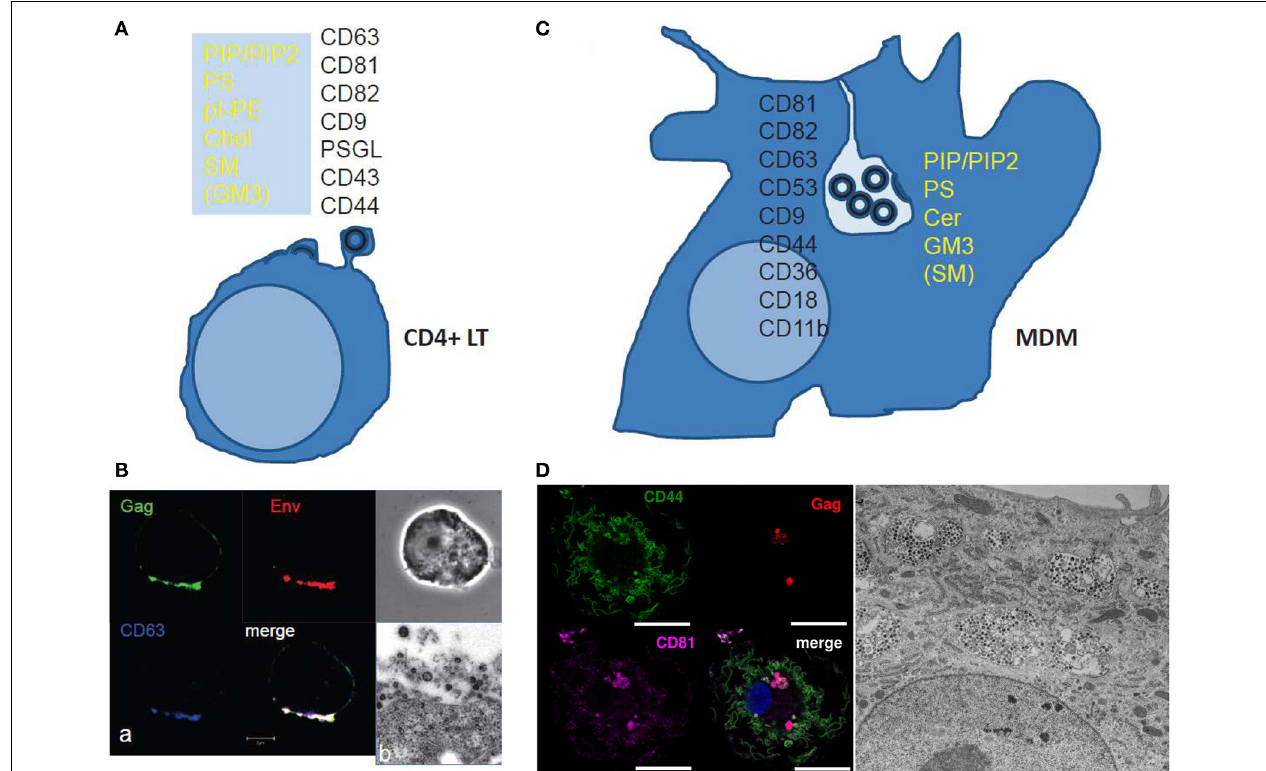
FIGURE 2 | Scheme and images of HIV assembly at the cellular level. (A) Membrane cell proteins and lipid composition that are found in the virus membrane issued from CD4 + T cell lines or at polarized T cell uropods. From Brügger et al. (2006); Chan et al. (2008); and Lorizate et al. (2013) for the virus lipid membrane composition. From Grigorov et al. (2006, 2009); and Nydegger et al. (2006) for the virus membrane protein composition. From Llewellyn et al. (2013)fortheGagcontainingTcelluropodmicrodomains. (B) HIV-1assemblyin chronically infected MOLT cells as shown by immunofluorescence confocal for Gag,EnvandthecellCD63tetraspanin(a)andelectron(b)microscopy.(a)HIV-1 infected MOLT cells were fixed in 3% PFA and stained for Gag with an anti-MAp17, anti-gp120, and anti-CD63 for immunofluorescence confocal imaging. (From D. Muriaux lab.) (b) HIV-1 infected MOLT cells were fixed with 2.5% glutaraldéhyde, embedded and thin-sectioned for electron